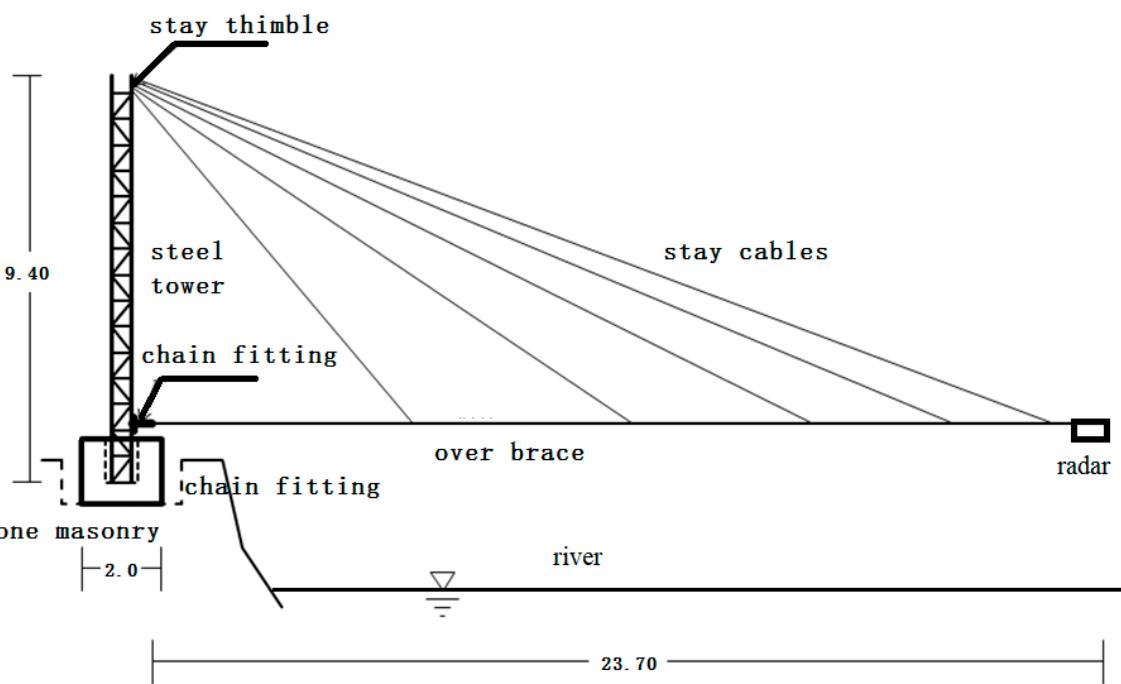
( b ) Figure 4. Site drawing of installed equipment. ( a ) Radar equipment from bank view; ( b ) radar equipment from river view. 2.3. Experimental Algorithm When the data are returned by the radar, they are processed and analyzed by the remote computer, enabling the ice thickness and the distance between the radar and the ice surface to be obtained. It is necessary to carry out layer tracking algorithm research on the ice surface and ice water interface and automatically analyze the ice thickness and the distance between the radar and the ice surface through the algorithm. This algorithm mainly uses the reflection wave form and intensity characteristics to capture the changes of the ice water interface and ice/water air interface by tracking the event to calculate the ice cover thickness, water surface, and ice distance from the radar. The basis of the algo- rithm is to extract the transmitting layer and identify the homogeneity and similarity of reflected waves in the same formation. The two properties are used to track the reflect- ing layer. (1)